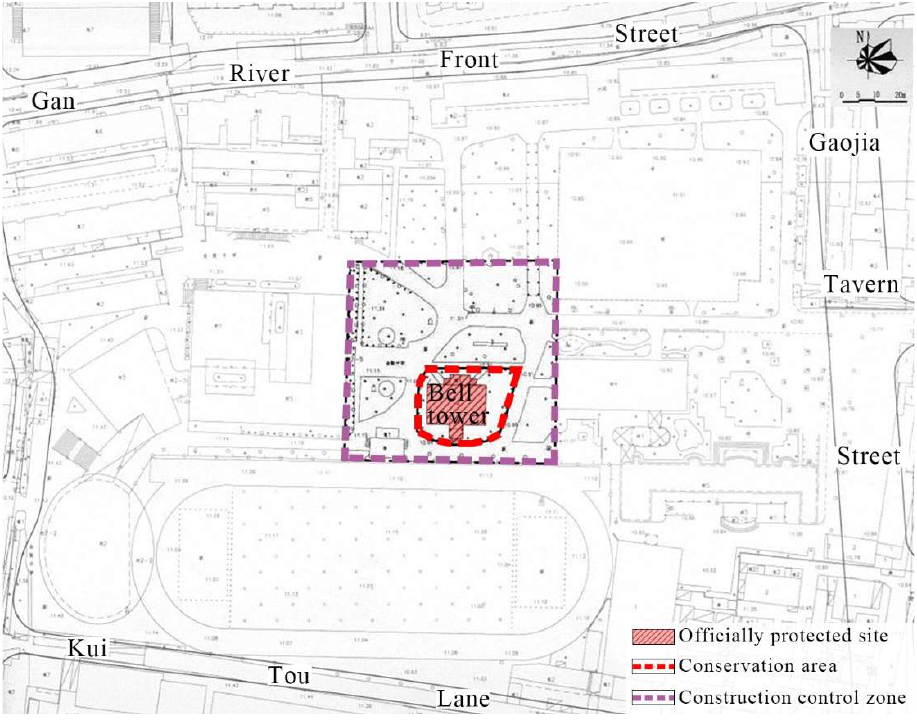
Figure 18. Set up a conservation scope and construction control zone (source: author).